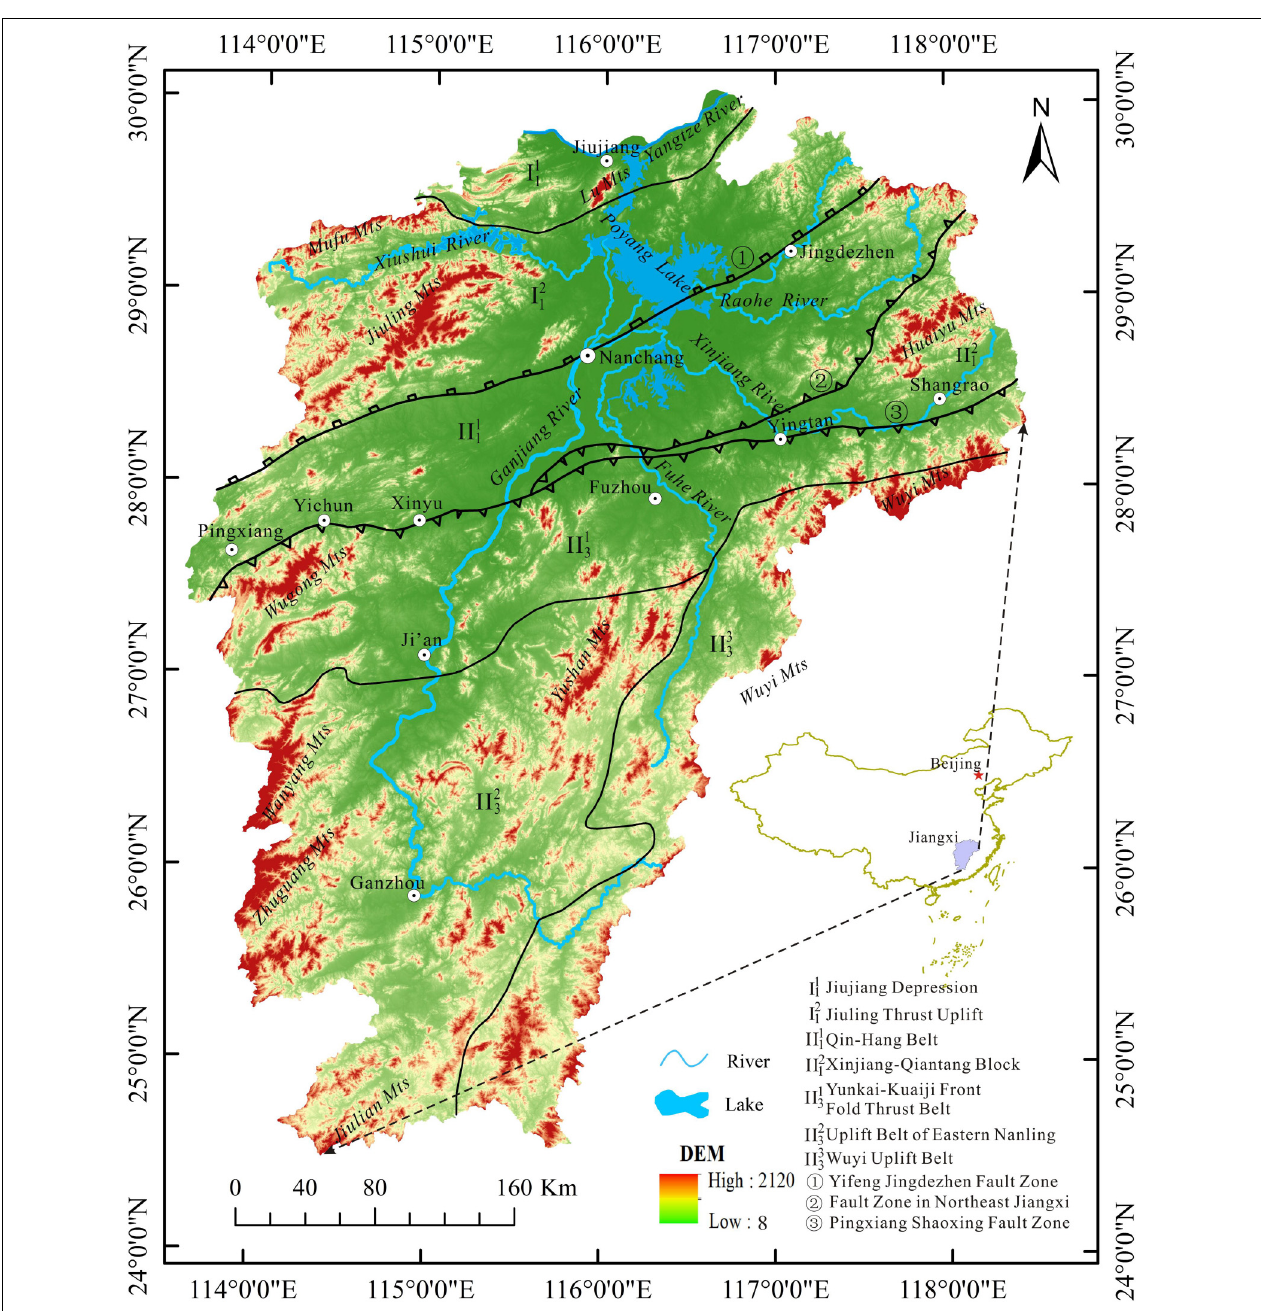
FIGURE 1 | Location of the study area, Jiangxi Province, and its main geotectonic units (Source: Geological Book of Jiangxi , Jiangxi Bureau of Geology, 2017).